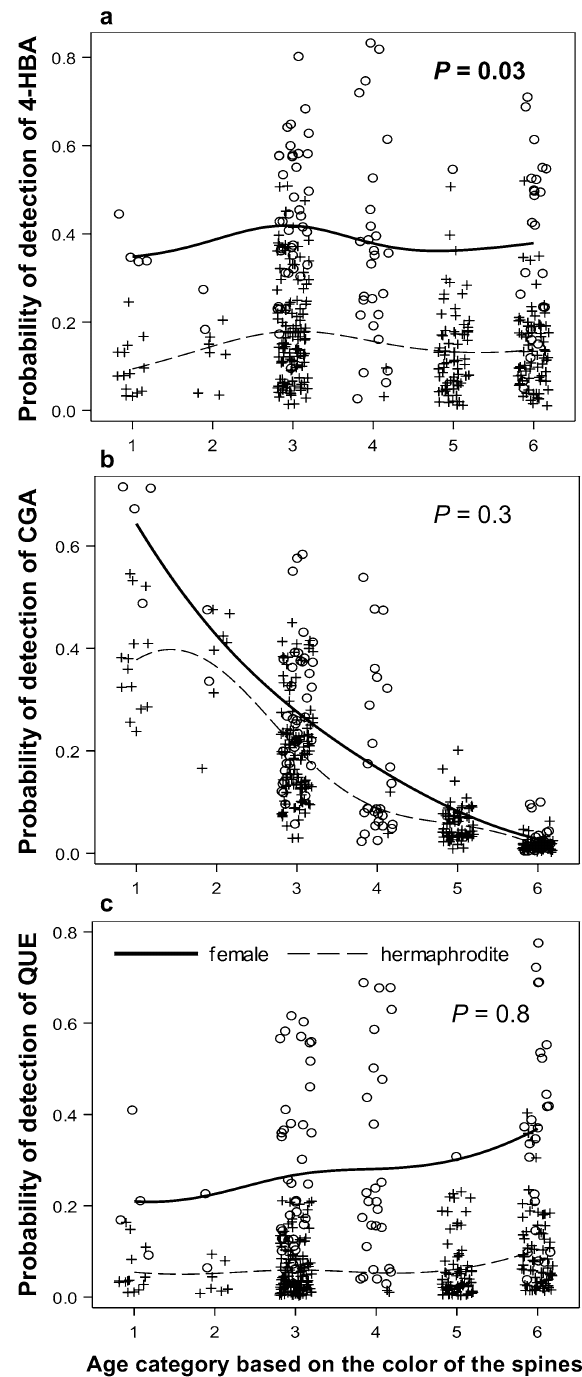
Figure 6. Effects of cladode age class on the proportion of cladodes containing a— 4-hydroxybenzoic acid (4-HBA), b— chlorogenic acid (CGA), and c— quercetin (QUE) in the vegetative tissues of female and hermaphrodite cladodes. The detection probability of 4-HBA showed the pattern previously predicted by Janczur’s (2009) model. P— probability of adjustment in the logistic regression model for pooled sexual forms. Cladode age classes are based on the spine colour: 1 — yellowish, 2 — yellow, white base, 3 — white yellowish, 4 — white, 5 — greyish, 6 — black, with ‘1’ and ‘6’, being the youngest and oldest age classes, respectively. Significant relationships at P ≤ 0.5 are marked with bold